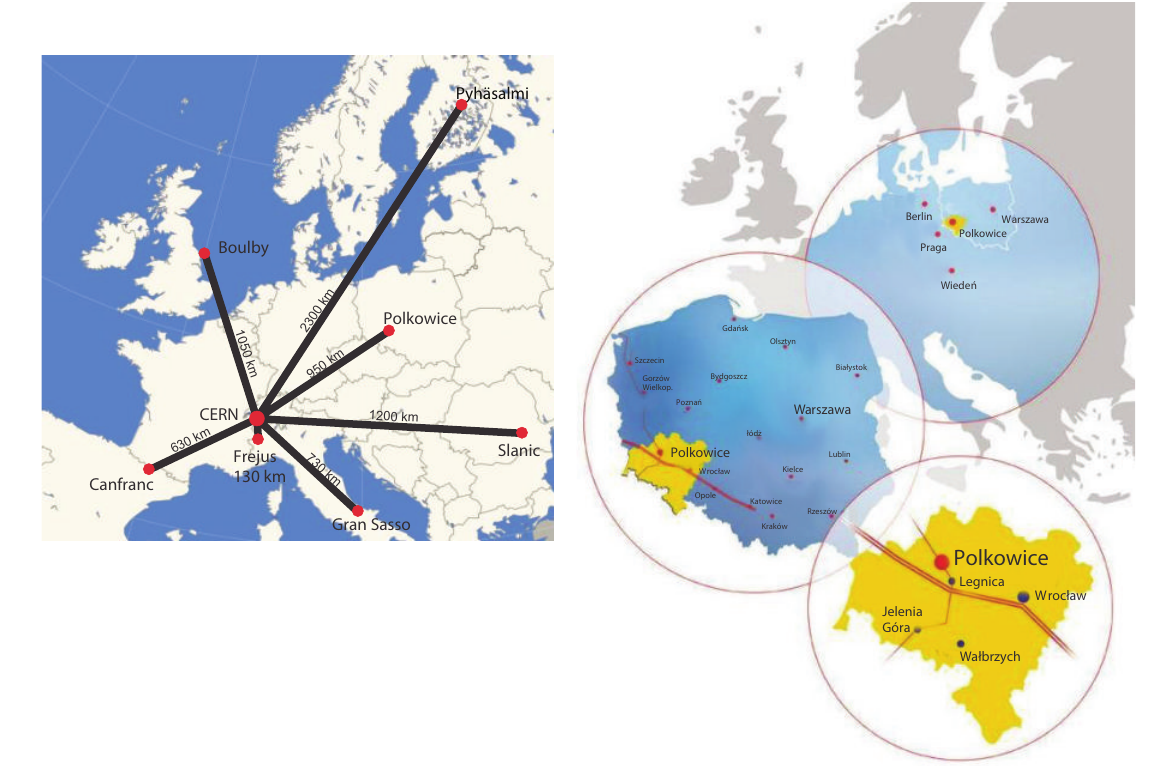
Figure 1: The sites considered in the LAGUNA project with the underlined location of the Polkowice-Sieroszowice copper ore mine in Polkowice town, Poland (on the basis of [1,